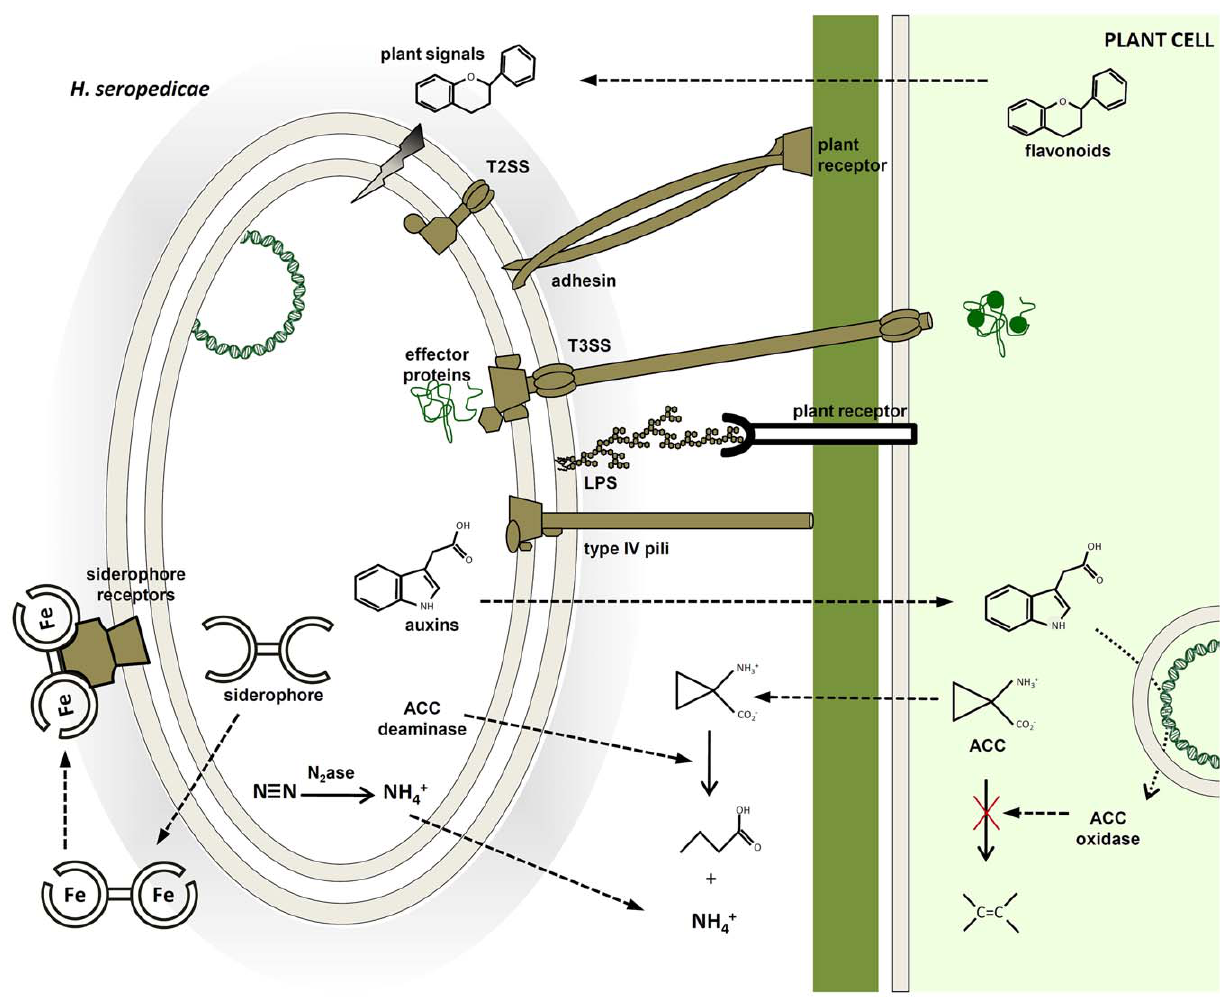
Figure 4. Molecular mechanisms probably involved in plant colonization and plant growth promotion identified in the H. seropedicae SmR1 genome. Plant signals can modulate the expression of bacterial genes coding for adhesins, type IV pili and enzymes of lipopolysaccharide (LPS) synthesis, triggering bacterial attachment to root surfaces. The molecular communication involves bacterial protein secretion and phytohormones to stimulate plant growth and modulate plant defense response. In addition, modulation of plant ethylene levels by ACC deaminase may contribute to plant growth promotion. The success of the endophytic association depends on a compatible genetic background that leads to benefits for both